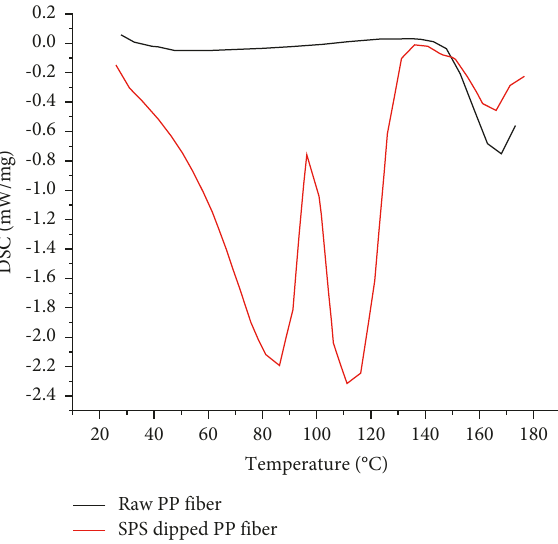
Figure 7: DSC of raw and SPS-dipped PP